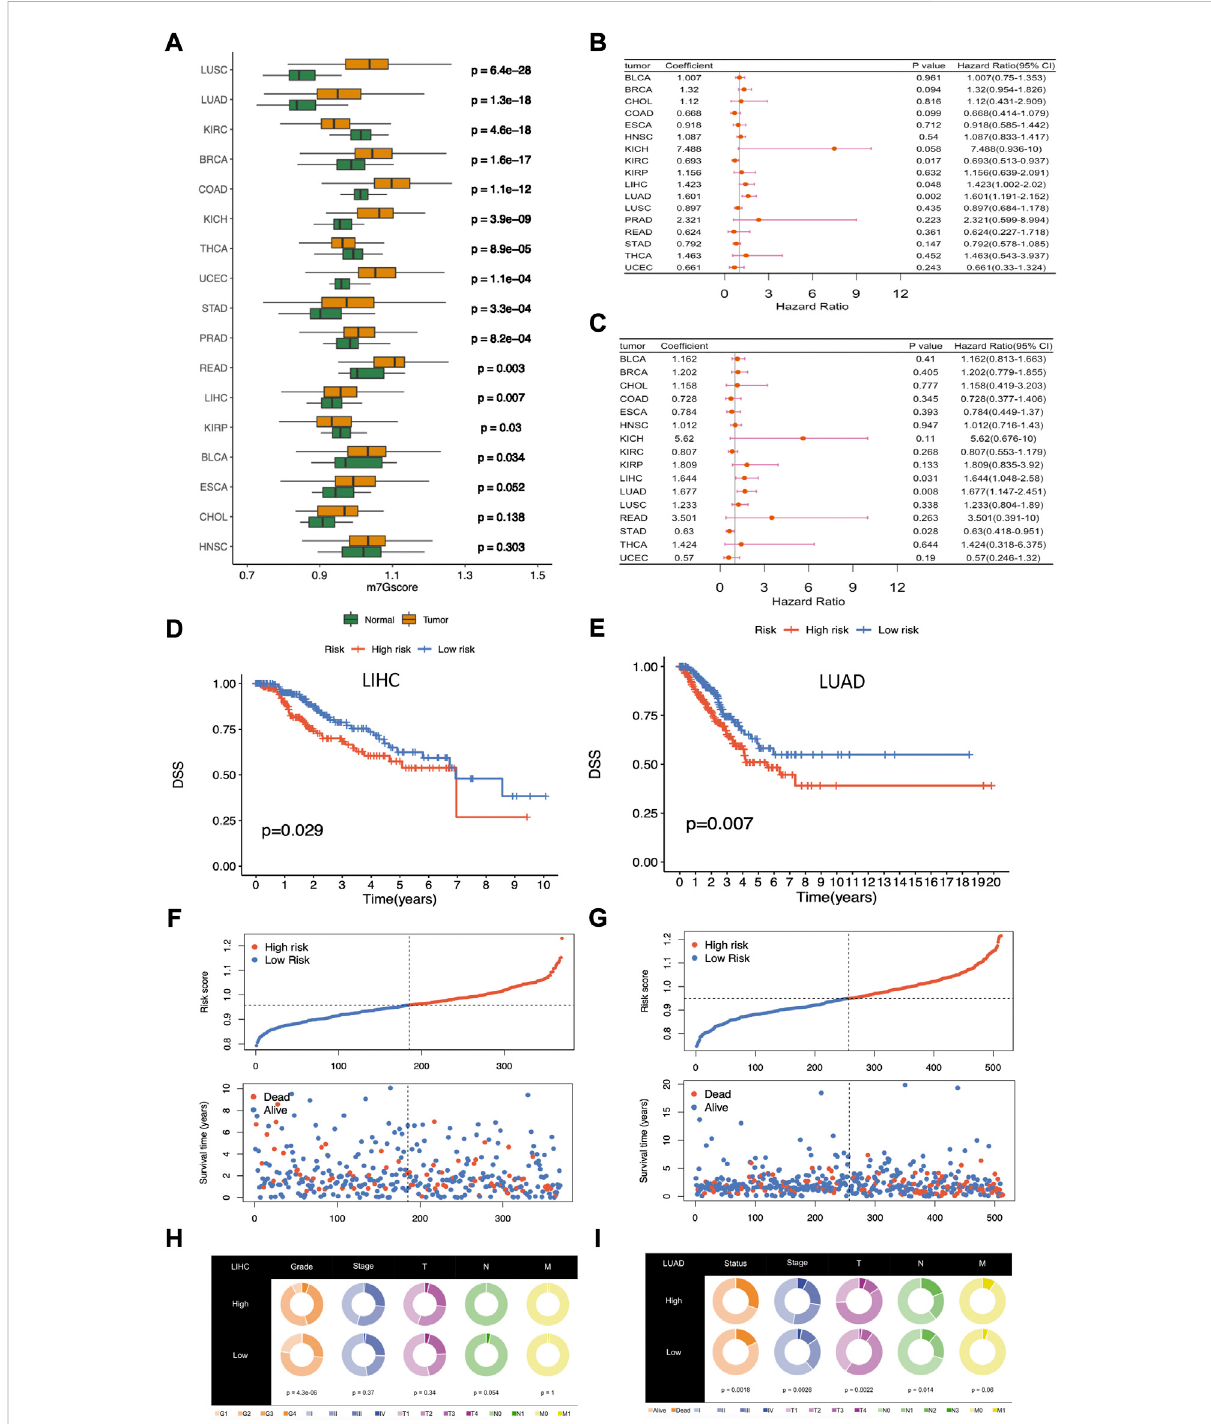
FIGURE 5 Differential analysis and clinical relevance of the m7Gscore across cancers. (A) Differential analysis of m7Gscore between tumor and normal patients across cancers. (B) Univariate Cox regression analysis of m7Gscore related to OS across cancers. (C) Univariate Cox regression analysis of m7Gscore related to DSS across cancers. (D) Kaplan-Meier survival analysis of OS in the two risk groups strati fi ed by m7Gscore in LIHC. (E) Kaplan- Meier survival analysis ofDSSinthe tworisk groupsstrati fi edbym7GscoreinLUAD. (F) Distribution ofm7Gscoreand survivalstatus inLIHC. (G) Distributionofm7GscoreandsurvivalstatusinLUAD. (H) PiechartofthemainclinicopathologicfeaturesinthetworiskgroupsinLIHC. (I) Piechartof the main clinicopathologic features in the two risk groups in